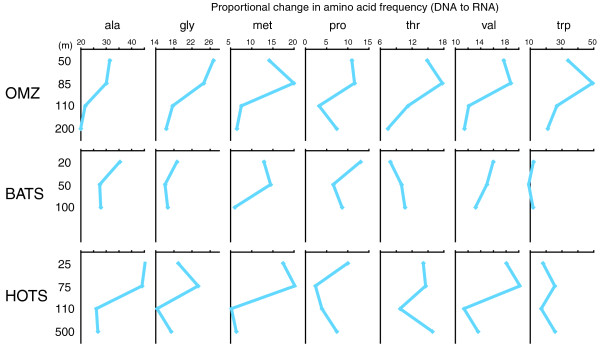
Proportional changes in amino acid usage decrease with depth. Data include the seven amino acids with the greatest proportional increase from DNA to RNA. Proportional change = ((Amino acid proportion in RNA) - (Amino acid proportion in DNA))/(Amino acid proportion in DNA) × 100.